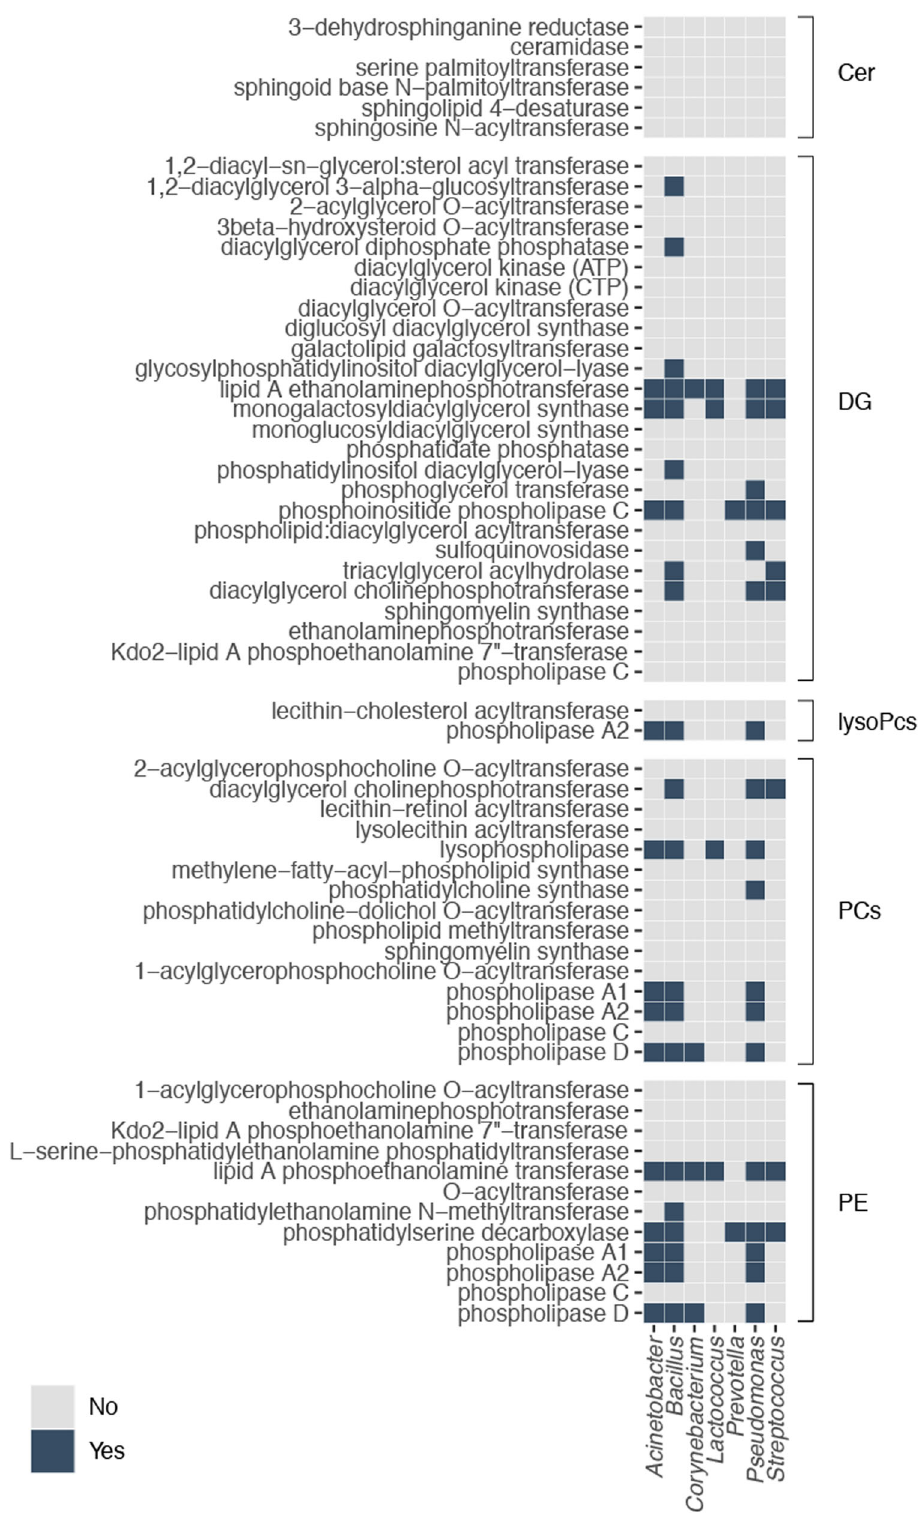
Fig. 4 Enzymatic potential of bacterial genera for lipid biosynthesis. Heatmap describing the presence or absence of the genes required for the biosynthesis of lipids in the bacterial genera identi fi ed to differ between the study groups. Enzymes are divided according to the biosynthetic pathway. Blue signi fi es that the gene required for the synthesis of the enzyme of interest has been annotated in the genome of the genus presented on the X axis. Cer ceramide, DG diacylglycerol; lysoPC, lysophosphatidylcholine; oxCE, oxidized cholesteryl ester; PC, phosphatidylcholines; PE, phosphatidylethanolamines.